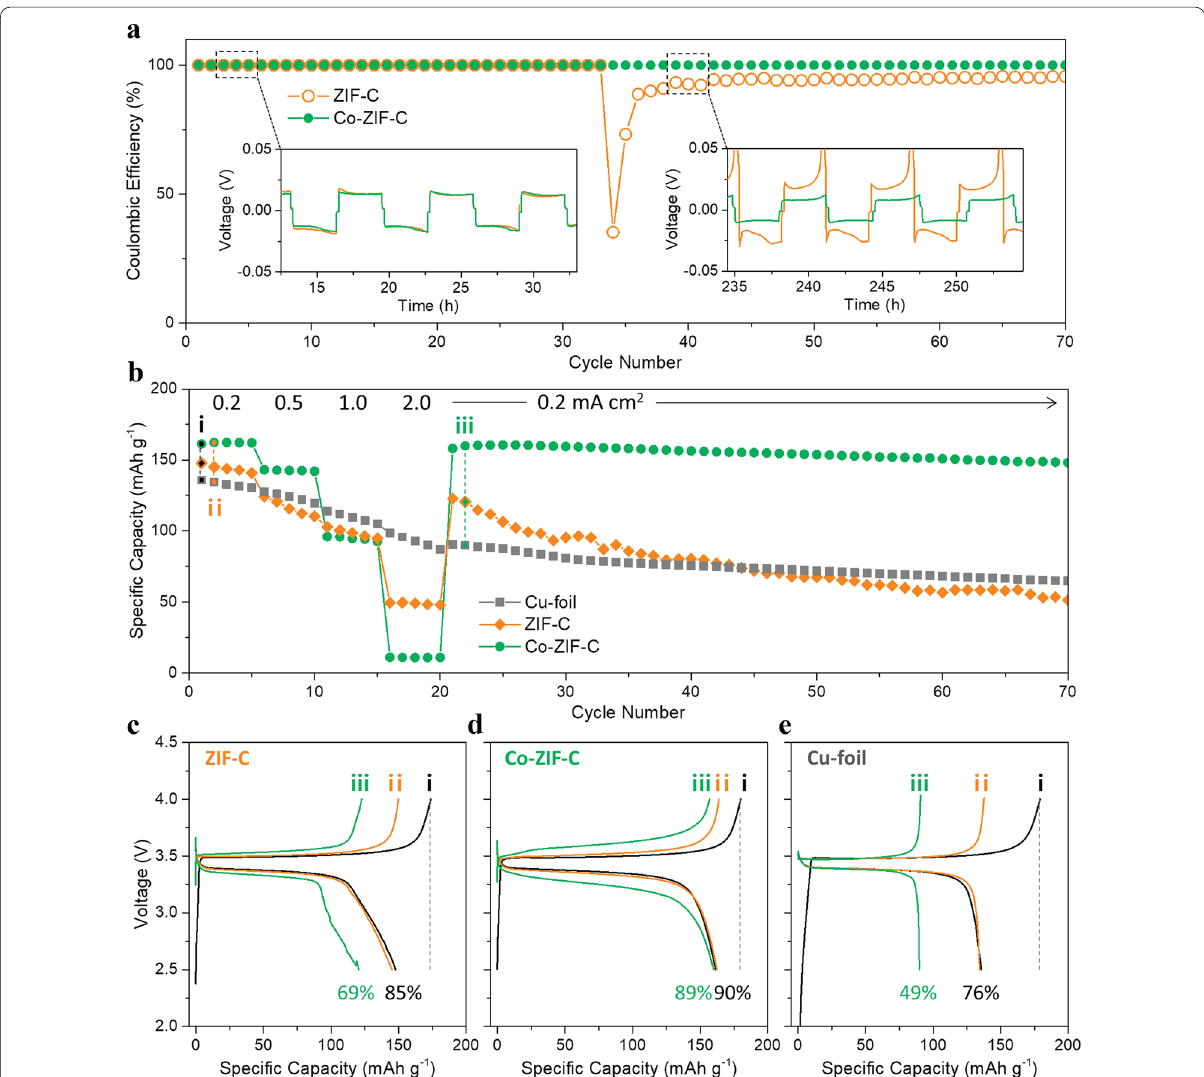
Fig. 2 a Coulombic efficiencies of each cycle for the ZIF‑C and Co‑ZIF‑C electrodes (half‑cells) and their voltage hysteresis observations (in insets), b full‑cell test results at different current densities, and the charge–discharge plots of ( c ) ZIF‑C electrode, d Co‑ZIF‑C electrode, and e Cu‑foil reference